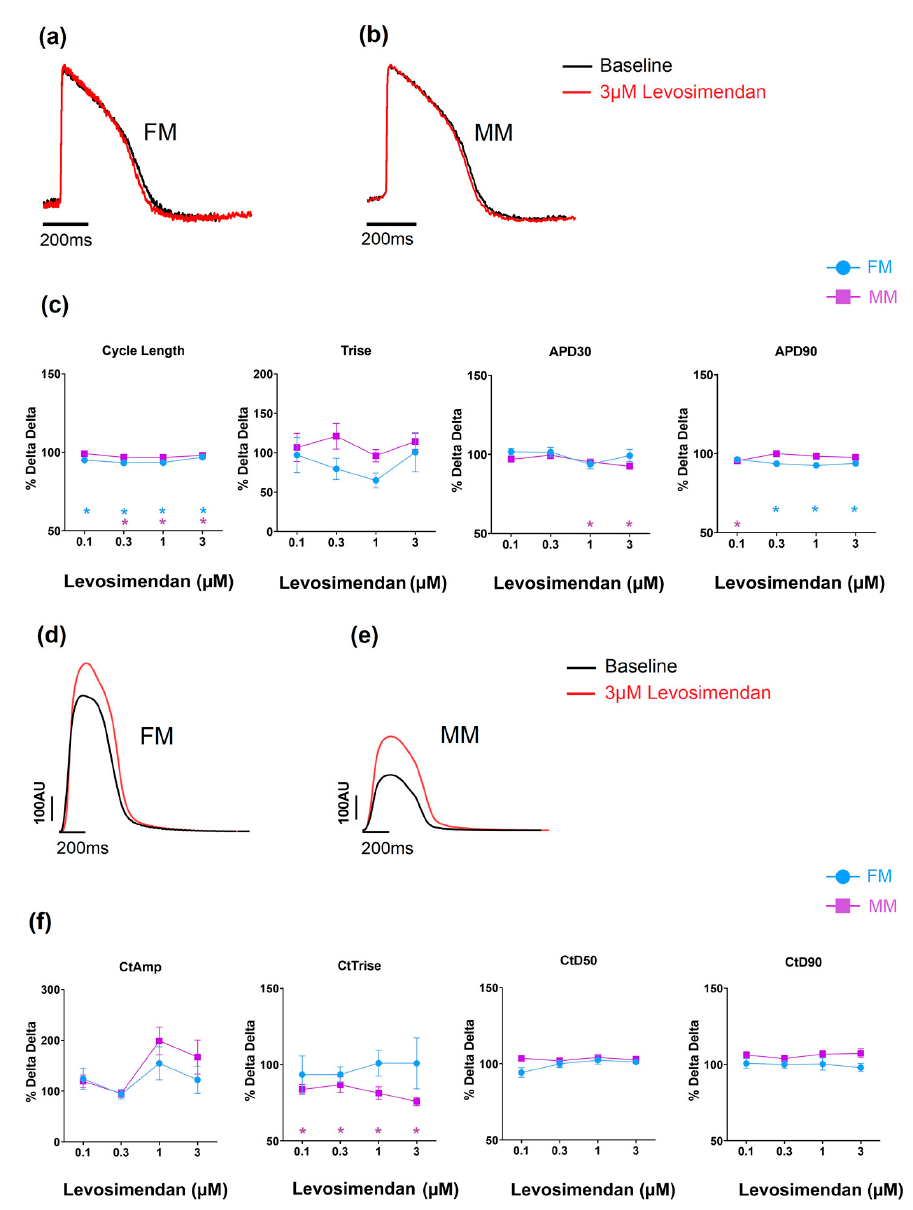
Figure 5. The effect of levosimendan on electrophysiology ( a – c ) and contractility ( d – f ). * p < 0.05 with fibronectin (FM) (blue) and Matrix Plus coated plates (MM, violet).